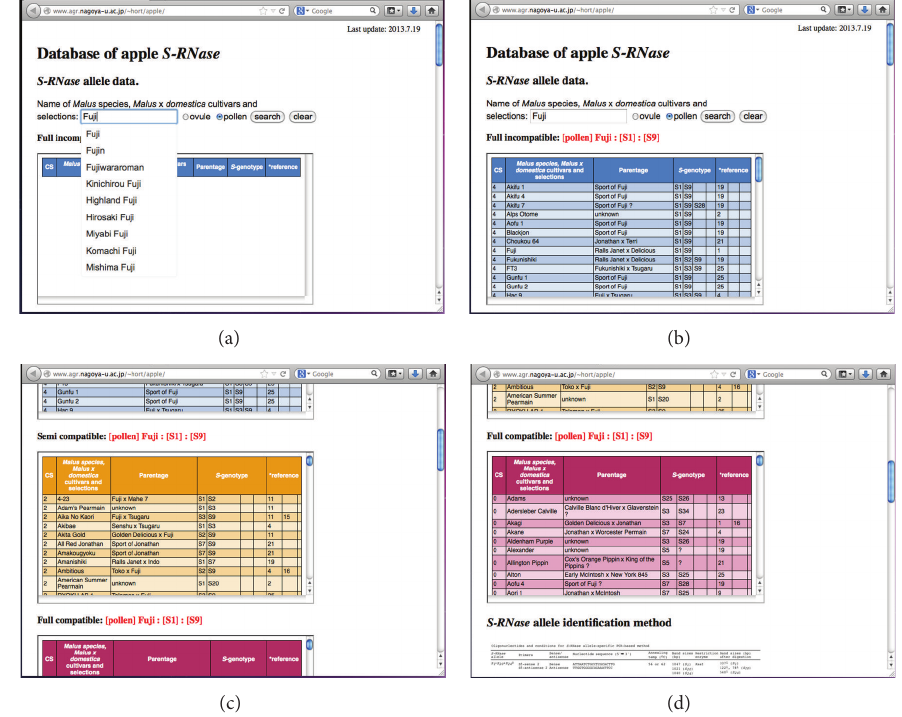
Figure 3: Representative screen shots of the search system. (a) “Fuji” was selected to search cultivars for investigation of cultivars, species, and selections showing full-, semi- and incompatibility with “Fuji.” (b) Search result: cultivars incompatible with “Fuji.” (c) Search result: cultivars semicompatible with “Fuji.” (d) Search result: cultivars fully compatible with